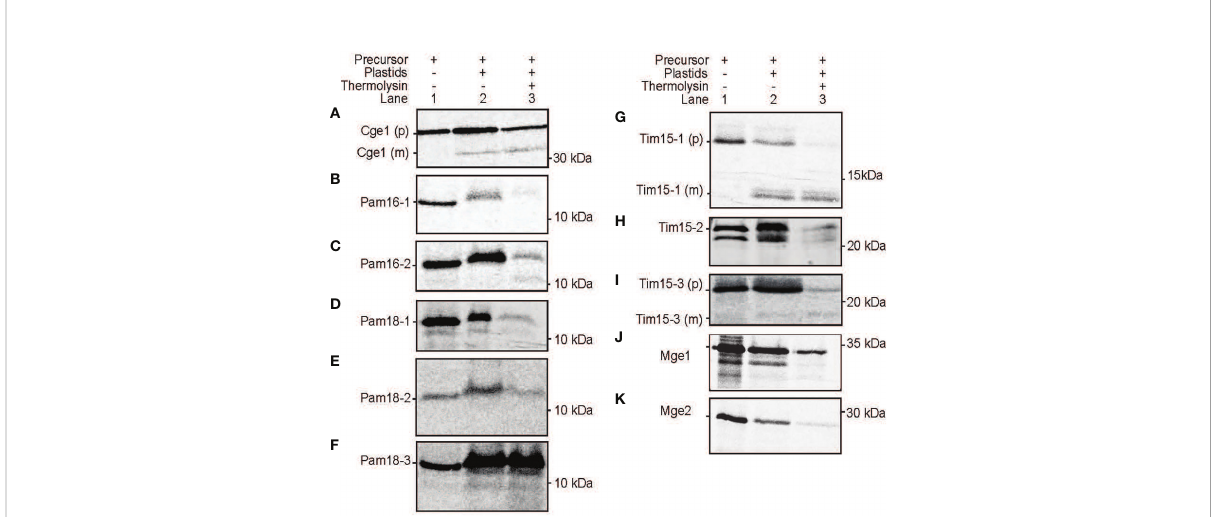
FIGURE 9 Protein import assays into isolated plastids. Import of radiolabelled proteins into isolated Arabidopsis plastids. Cge2 was used as a control for successful import (A) . Pam16 (B, C) , Pam 18 (D-F) , Tim15 (G-I) , Mge1 (J, K) . Lane 1 = precursor protein alone, lane 2 = precursor protein incubated with chloroplasts under conditions that support import, lane 3 = as lane 2 with the addition of thermolysin following import. (p) = precursor protein band. (m) = mature protein band. Position of protein size marker is shown on the right.